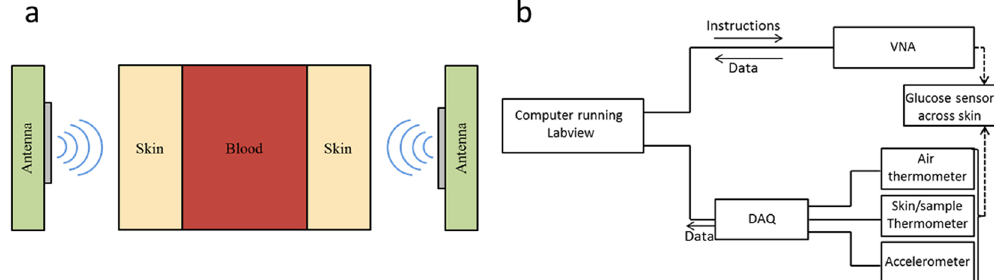
Figure 1. The sensor design and principles. ( a ) The mm-wave glucose sensor concept set-up with two patch antennas. The skin/blood/skin patient area or a tank is placed in between the two antennas. ( b ) A schematic of the sensor system with data and instruction flow controlled by